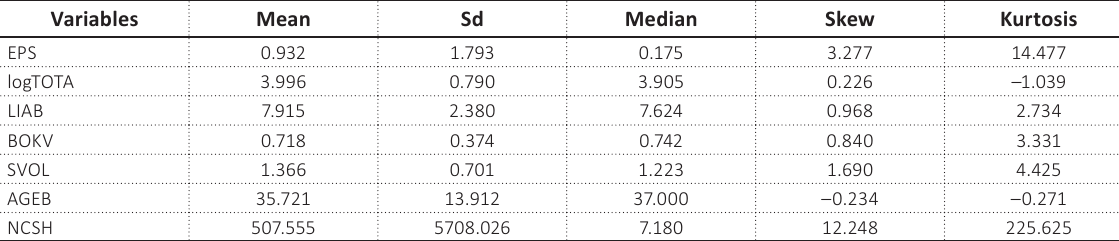
Table 1. Descriptive statistics for the study variables